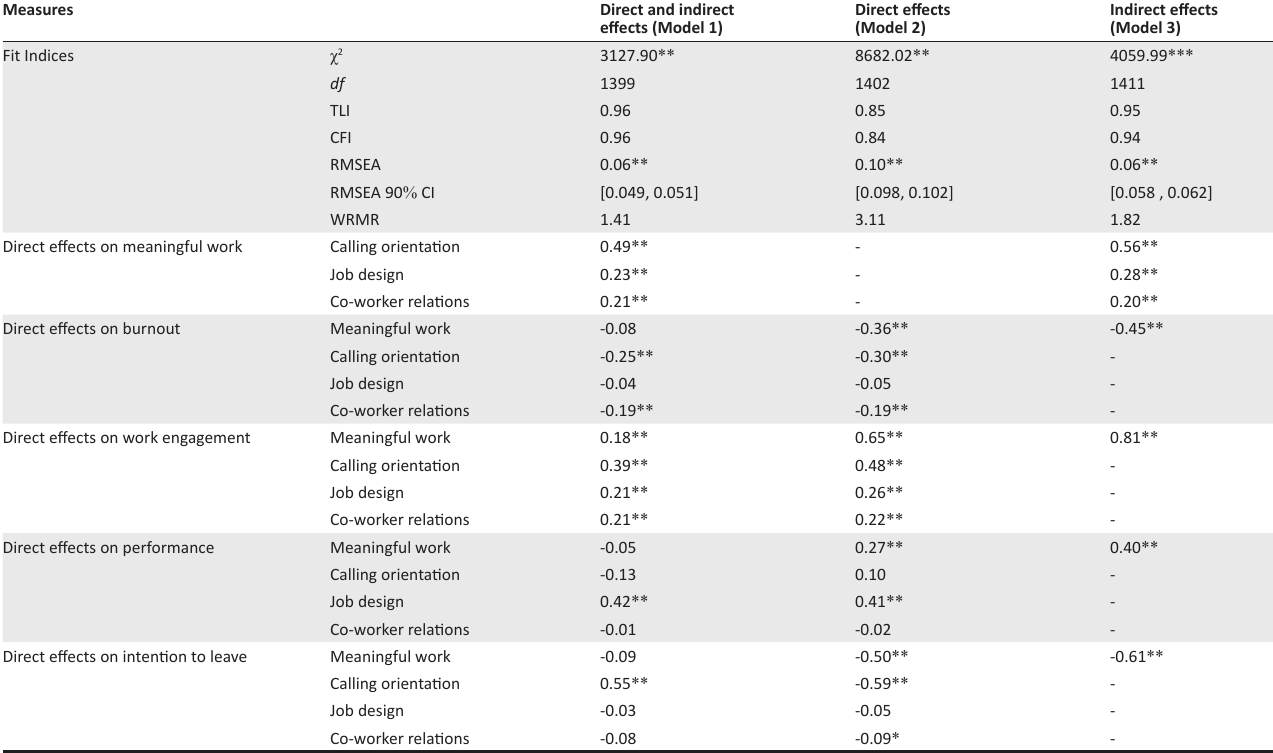
Table 4: Fit indices and standardised path coefficients of the structural models. Measures